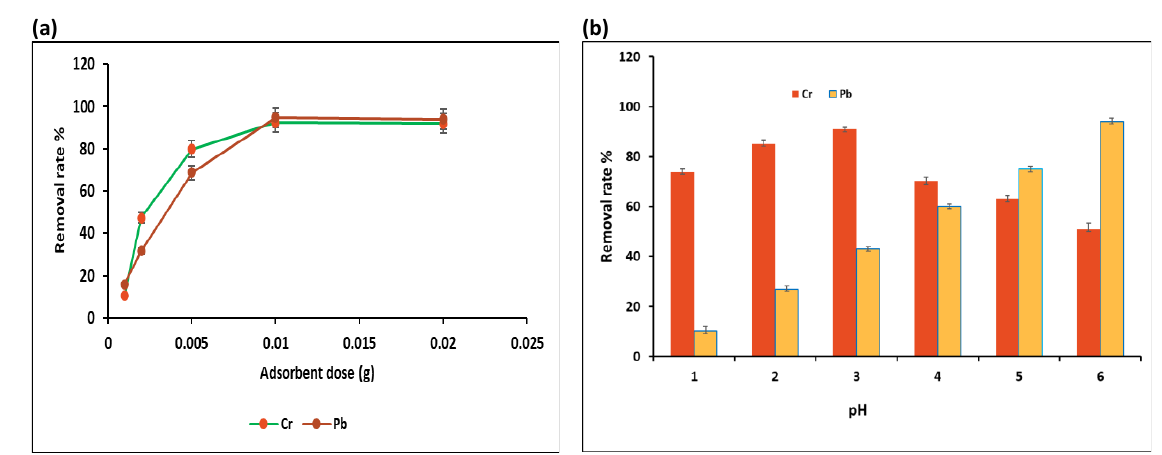
Figure 6. Removal (%) of Pb and Cr via GO-COOH as affected by initial adsorbent dose ( a ) and solution Ph ( b ) (C 0 = 100 mg/L, Temp. = 25 °C, shaking time = 60 min).